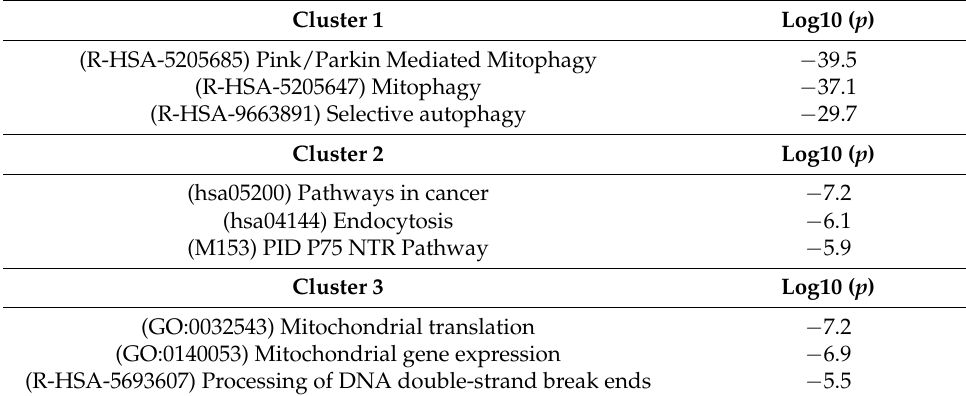
Table 2. Pathway (REACTOME, KEEG, Canonical) and GO-term enrichment analysis (top three best p